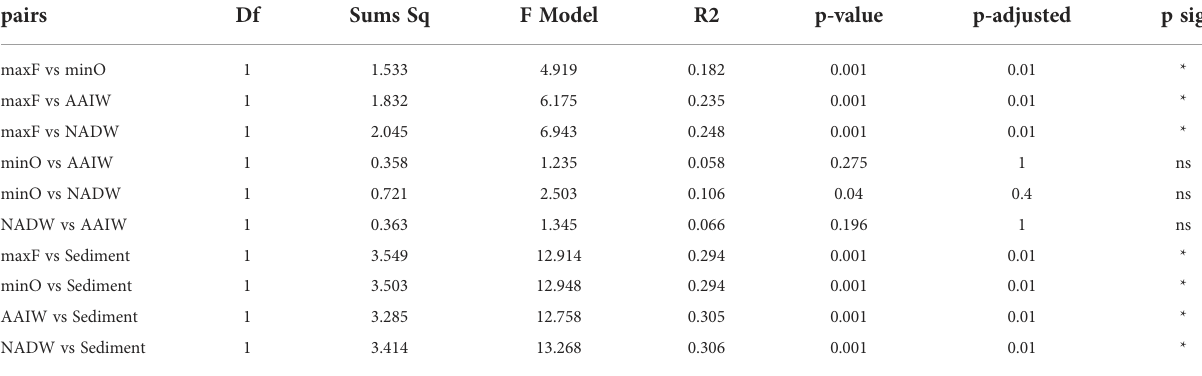
TABLE 3 Pairwise comparisons among water masses and sediment environments.